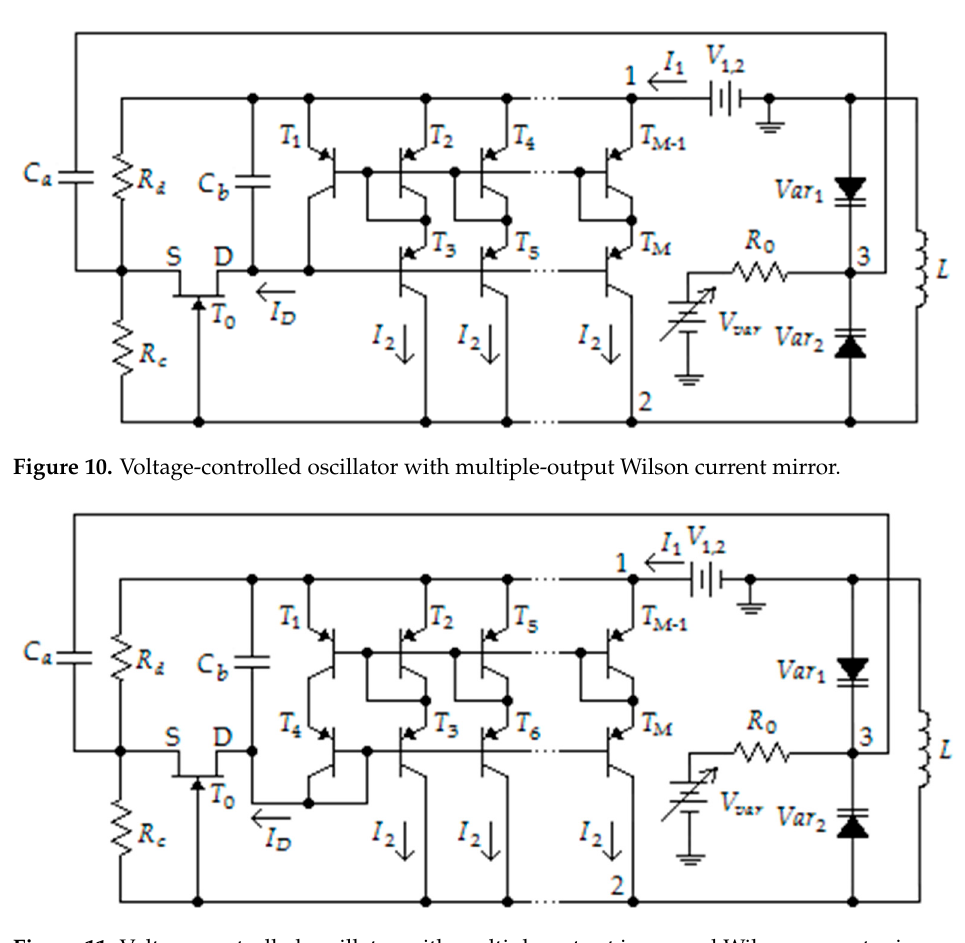
Figure 11. Voltage-controlled oscillator with multiple-output improved Wilson current mirror.